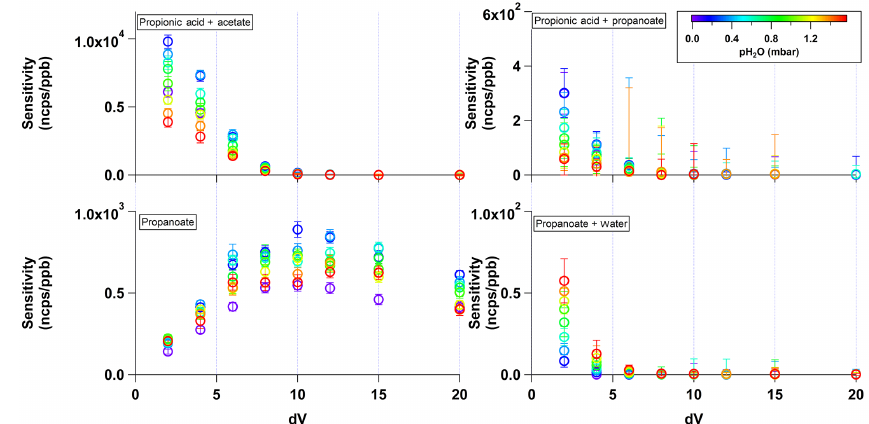
Figure 6. The sensitivity to propionic acid and related clusters is plotted against the voltage difference applied between the skimmer and BSQ front (component relation 5) in units of normalized counts per second per ppb (ncpsppb − 1 ). The points are colored by the calculated water vapor content in the IMR corresponding to changing the relative humidity from 0 to 80% under laboratory conditions.